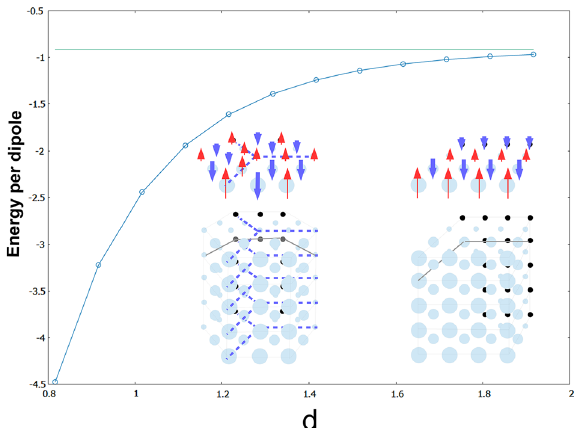
Figure 6. Plot of the evolution of the energy per particle in the thermodynamic limit as a function of the vertical cell distance d , for both the flag-state crystal and the 1/6-prism. The horizontal line corresponds to the asymptotic d energy per particle value of the flag state. See text for details. → ∞